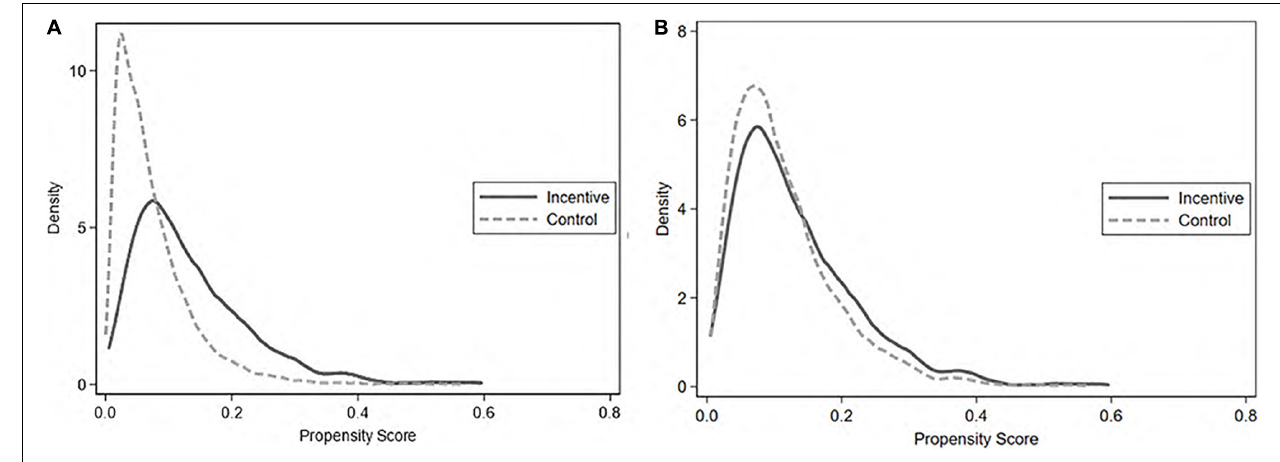
FIGURE 2 | Kernel density maps (A) before and (B) after